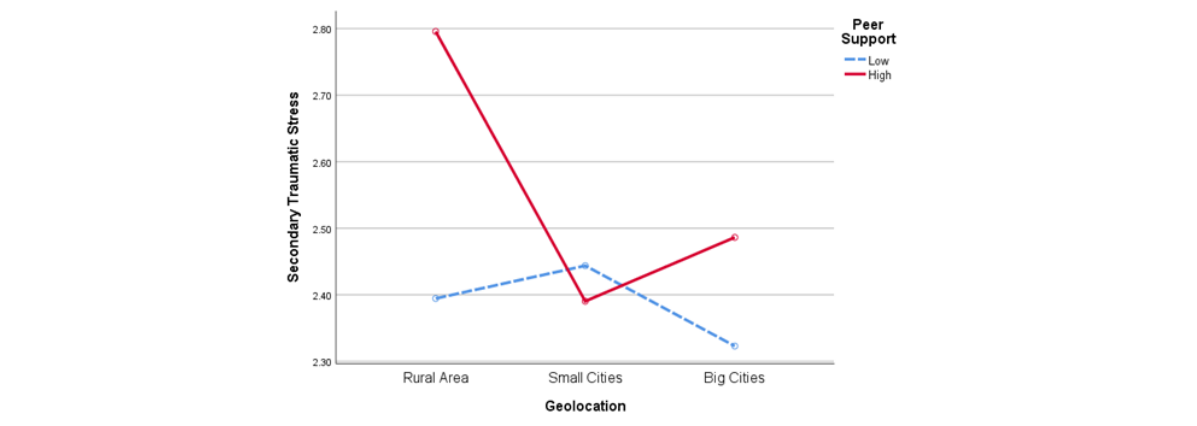
Figure 4. Interaction between geolocation and peer support for secondary traumatic